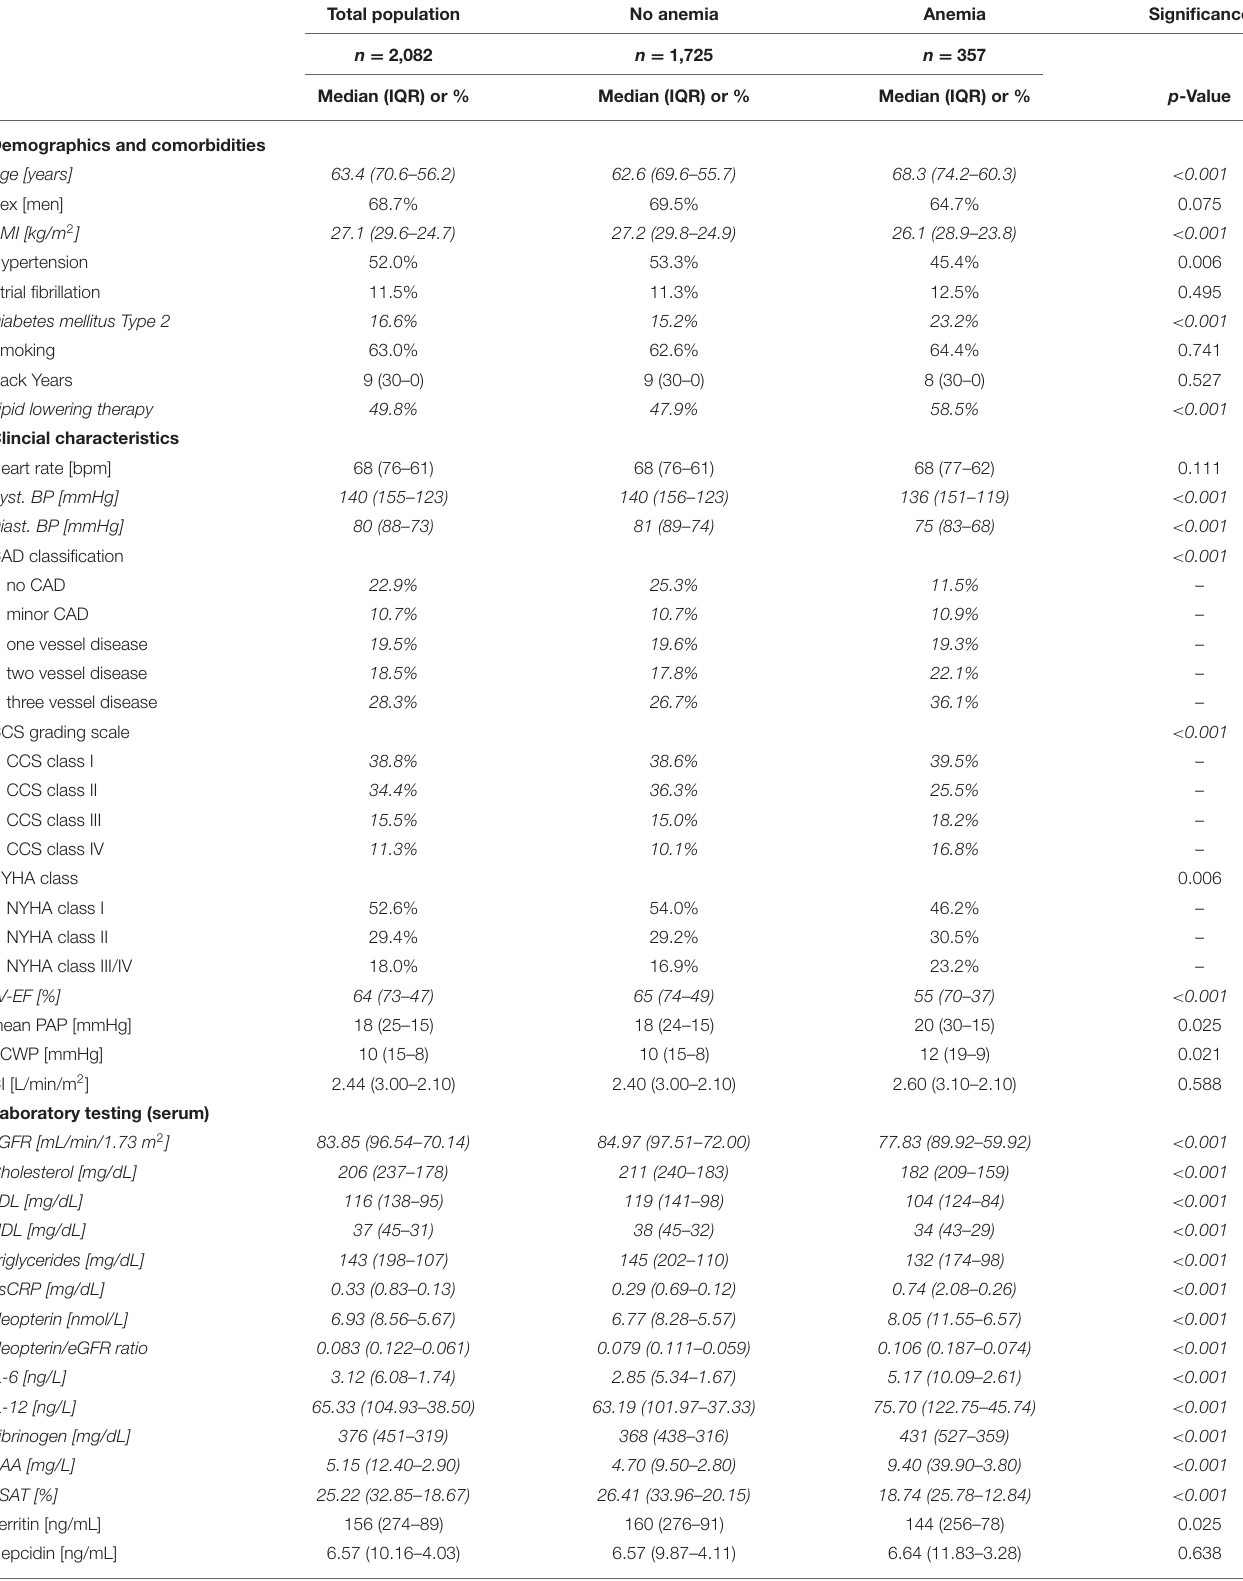
TABLE 1 | Baseline